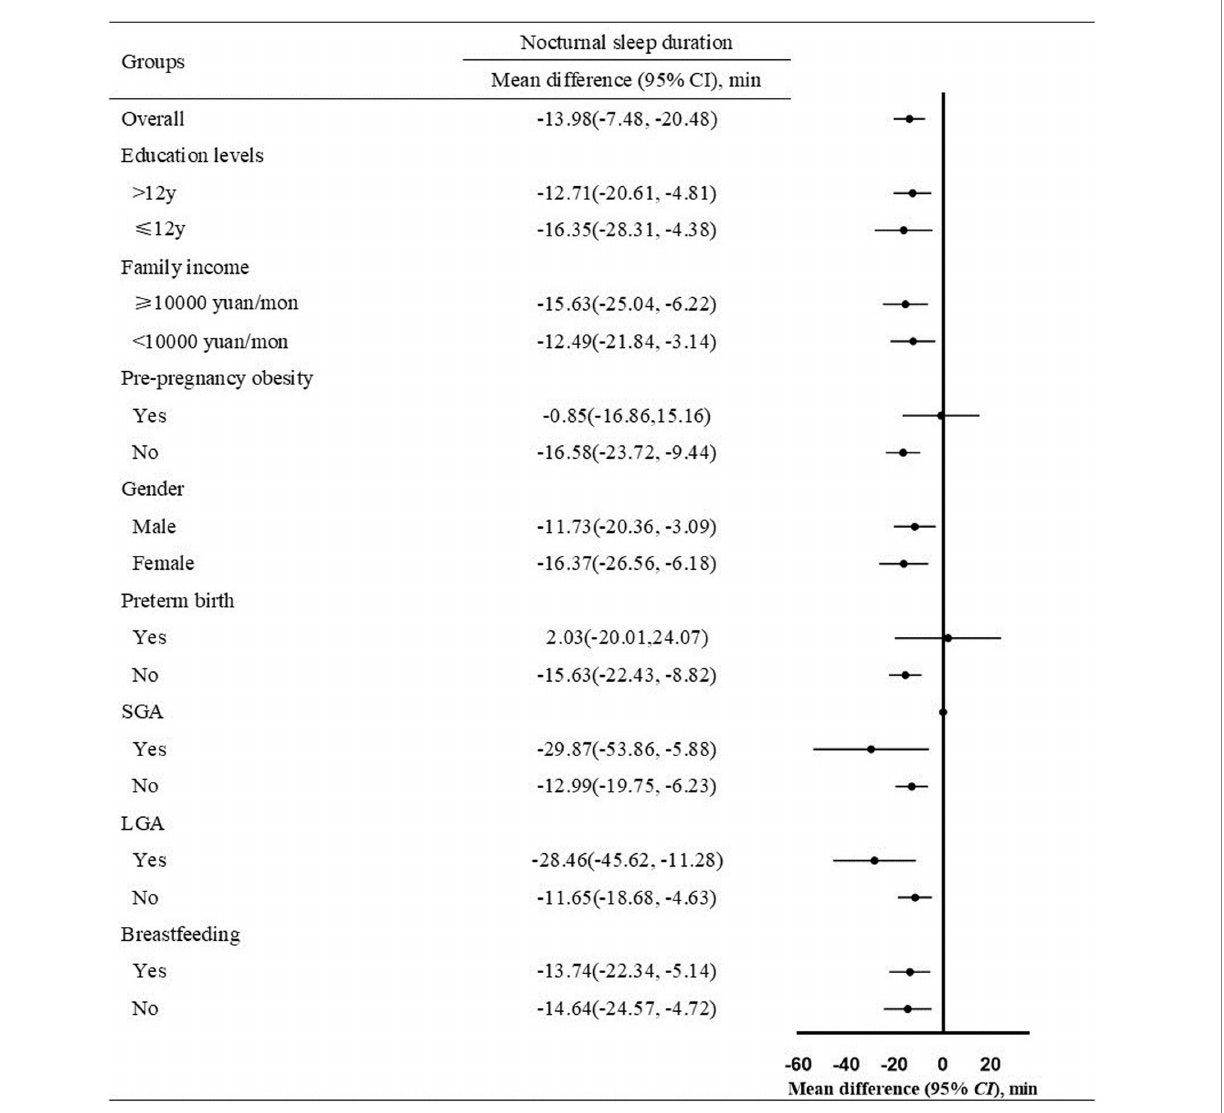
FIGURE 2 Mean difference of nocturnal sleep duration in infants born to mothers with anemia vs. mothers without anemia ( n = 1,347, Mean difference ± SD). Infants of the two groups were divided into subgroups according to maternal education levels, family income, pre-pregnancy obesity, infant gender, preterm birth, SGA, LGA, breastfeeding. The covariance analysis model adjusted for maternal age at delivery, education levels (if not stratified), family income (if not stratified), pre-pregnancy BMI (if not stratified), SBP, DBP, daily iron supplementation, maternal diet (fruits, dessert, vegetables, and bean products), infant gender, preterm birth, SGA (if not stratified), LGA (if not stratified), breastfeeding (if not stratified). SGA: small for gestational age; LGA: large for gestational age. BMI: body mass index; SBP: systolic blood pressure; DBP: diastolic blood pressure; SGA: small for gestational age; LGA: large for gestational